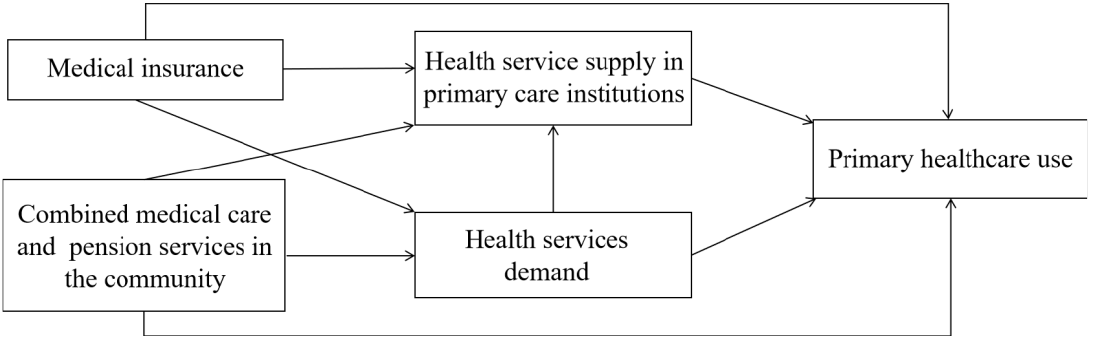
Figure 1. Analysis framework. The amount of healthcare services in PCIs should be read as the status of medical resources in the area where the individual samples are located. Combined medical care and pension services in the community are also read in this way.